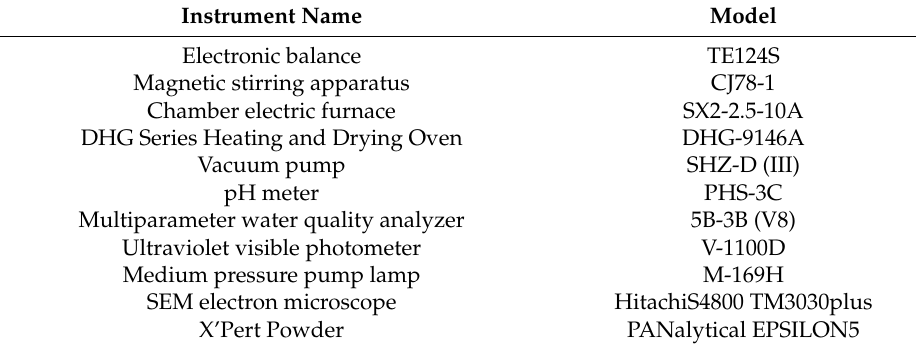
Table 2. The experimental instruments and